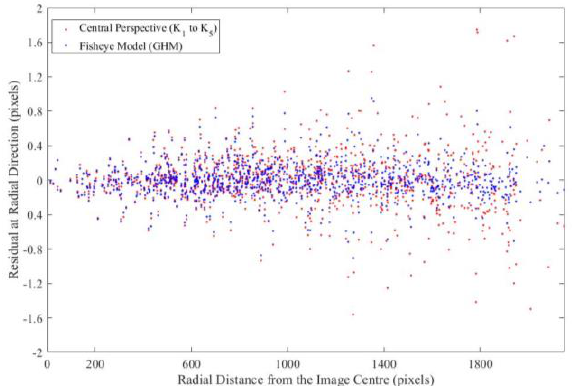
Figure 10. GoPro image residual absolute magnitudes in the radial direction between the central perspective model and fisheye GHM.